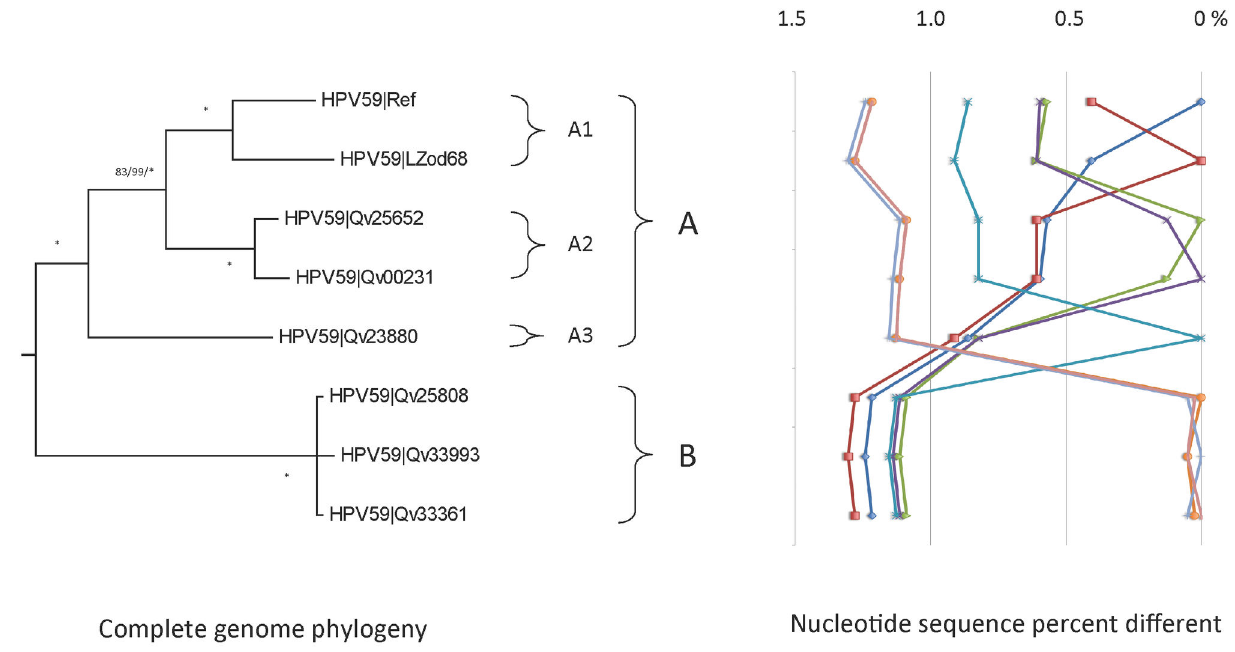
Figure 5. HPV59 variant tree topology and pairwise comparisons of individual complete genomes. The phylogenetic tree was constructed as described in Figure 2. Distinct variant lineages and sublineages were determined as described in Figure 2. The percent nucleotide sequence differences are shown in the panel to the right of the phylogenetic tree as described in Figure 2. doi: